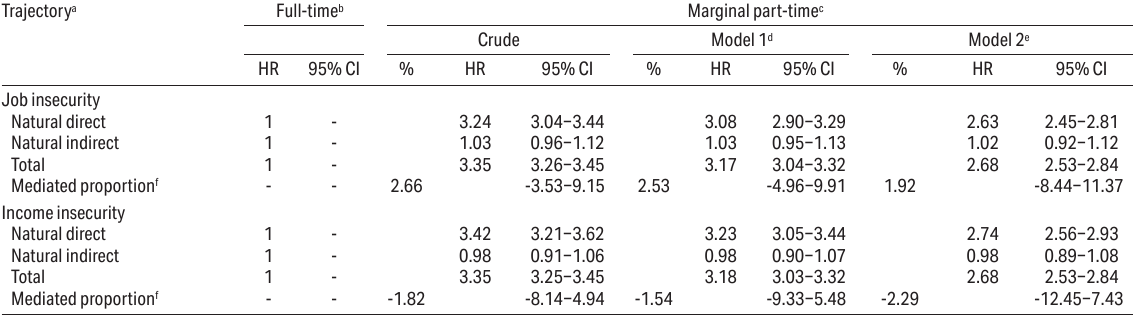
Table 3. Mediation analyses of job insecurity or income insecurity, in the relation between respective trajectories with marginal part-time work and depression (N=30